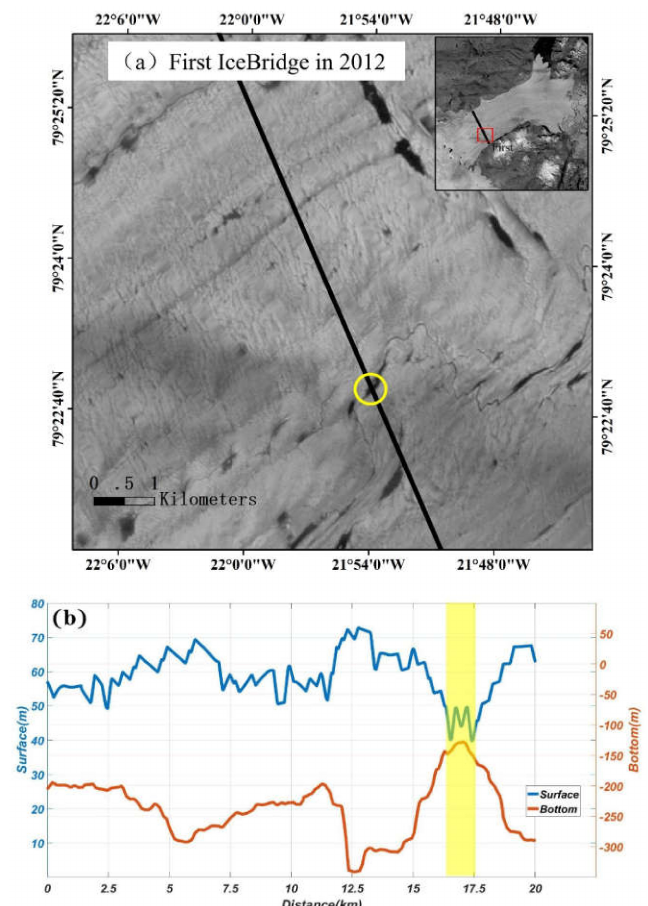
Figure 7. The first IceBridge in 2012 validates data and Landsat imagery. ( a ) shows the surface morphology at the first IceBridge data in 2012, with IceBridge airborne radar flight path (black solid line). The location indicated by the yellow circle is the area confirming the existence of the basal channel. ( b ) shows the results from the first IceBridge in 2012. The yellow area corresponds to the yellow circle in ( a ).